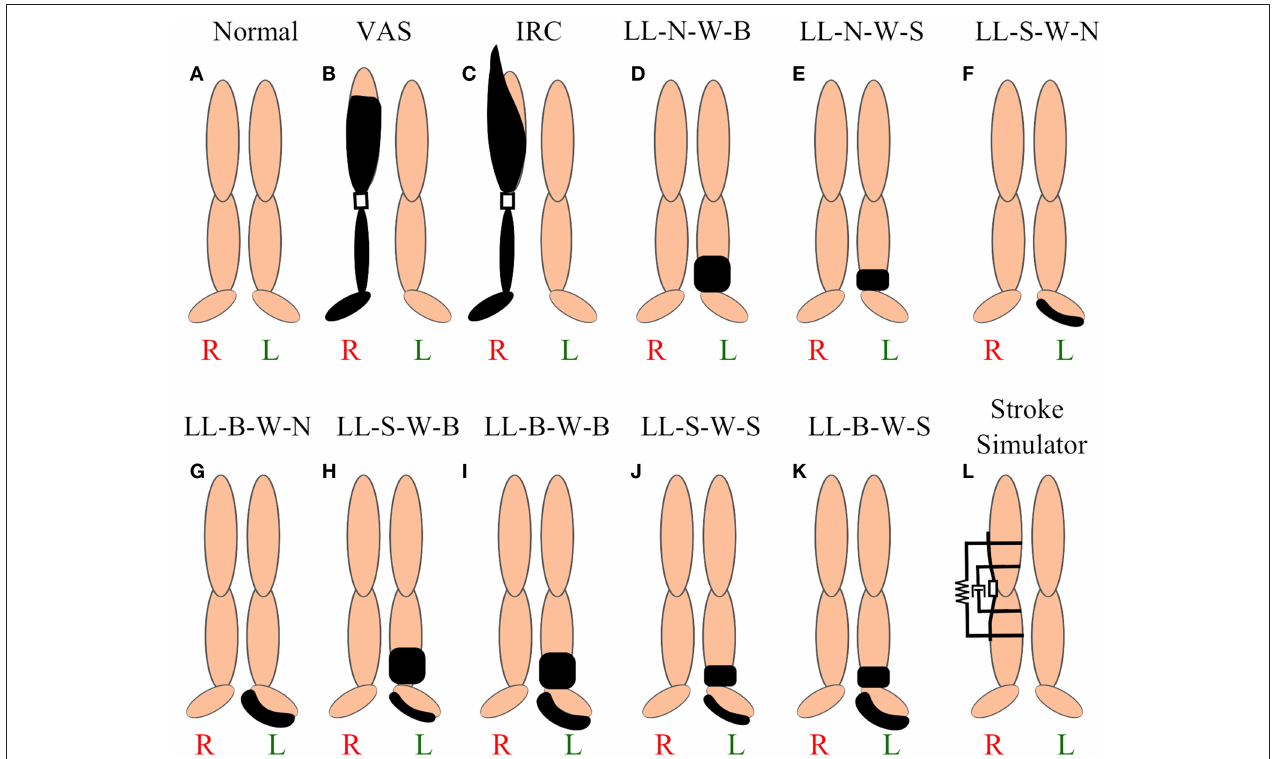
FIGURE 3 | Various perturbations. (A) Able-bodied subject, (B) vacuum assisted suspension brimless socket, (C) ischial ramus containment, (D) no leg length and no weight (LL-N-W-B), (E) no leg length and small weight, (F) small leg length and no weight, (G) big leg length and small weight, (H) small leg length and big weight, (I) big leg length and big weight, (J) small leg length and small weight, (K) big leg length and small weight, and (L) stroke simulator (Lahiff et al., 2016) with rotational damper and torsional